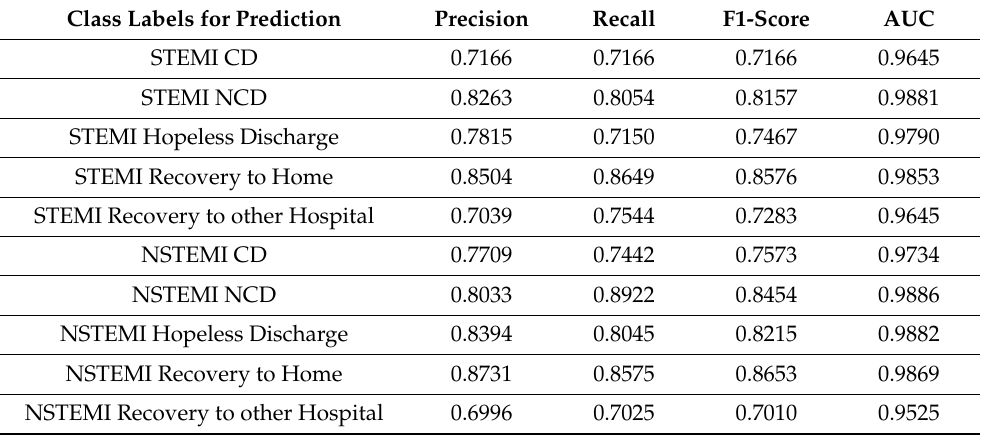
Table 5. Performance measures of all class labels for the Gradient Boosting Machine Classifier using in-hospital